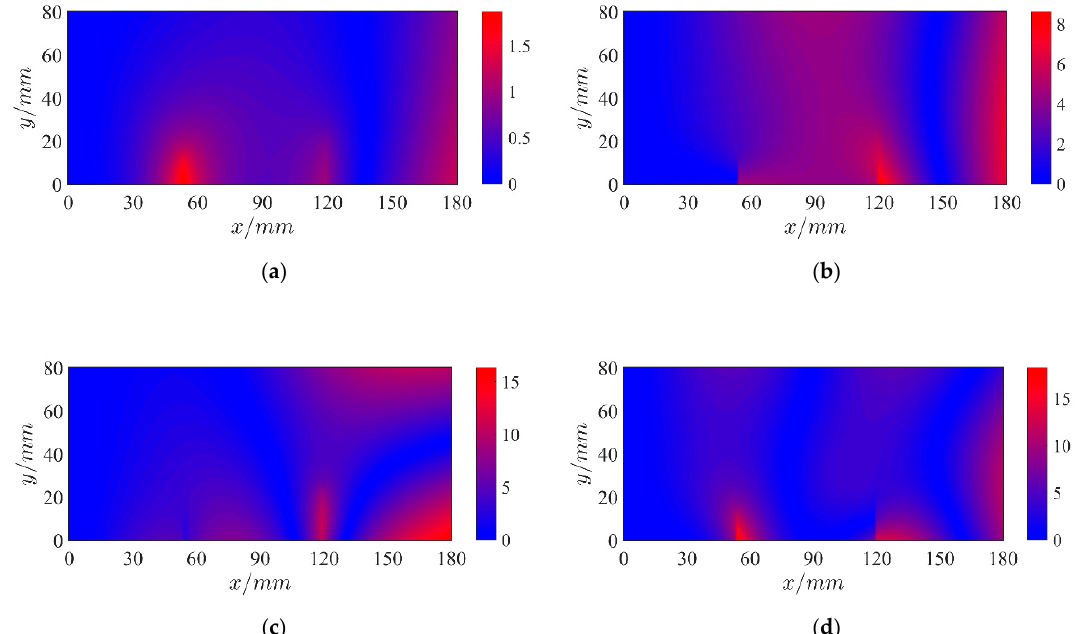
Figure 4. The colored plot of changes of the first four displacement mode shapes. ( a ) The first mode. ( b ) The second mode. ( c ) The third mode. ( d ) The fourth mode.